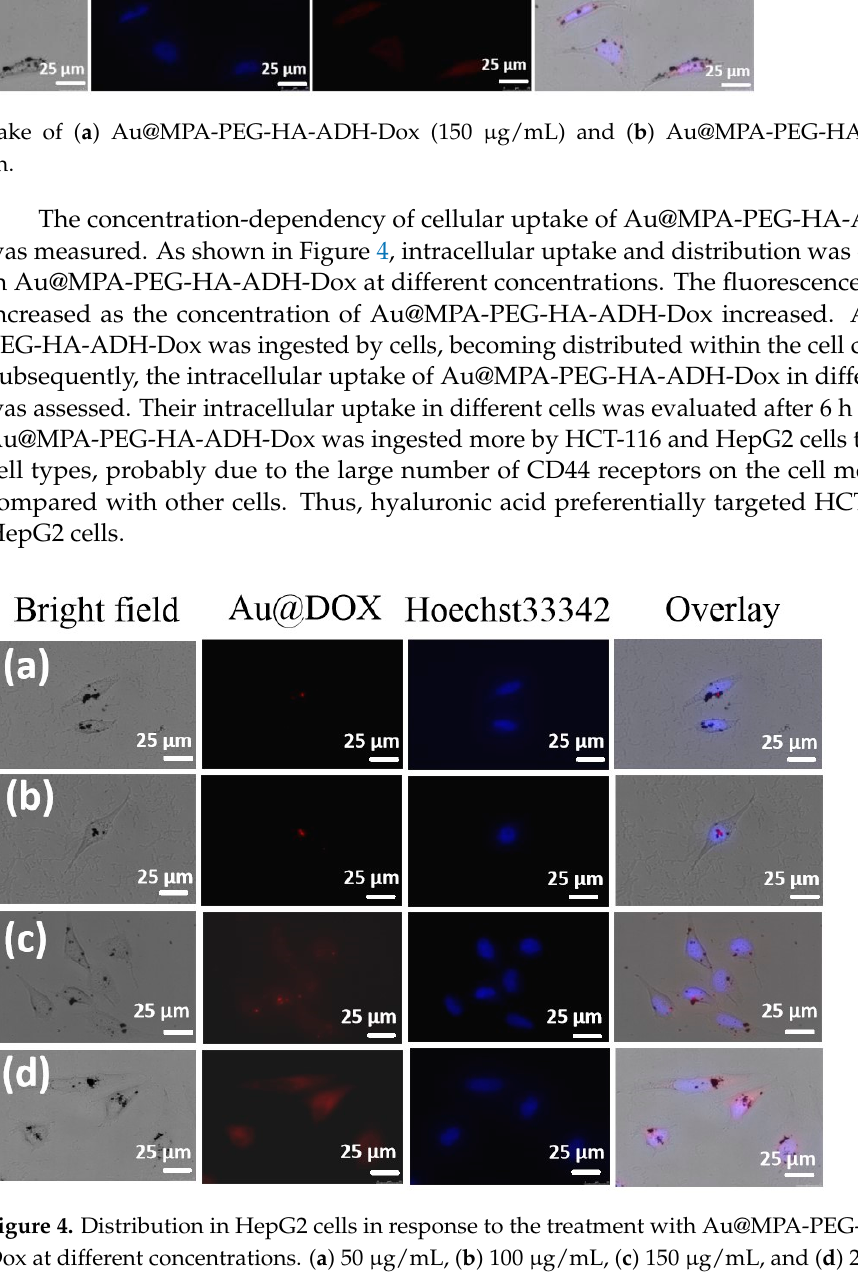
Figure 5. Distribution in different cell types in response to the treatment with Au@MPA-PEG-HA- ADH-Dox. ( a ) HepG2 cells; ( b ) HCT-116 cells; ( c ) SMMC-7721 cells; ( d ) Hela cells. Scale bar = 25 μ m.